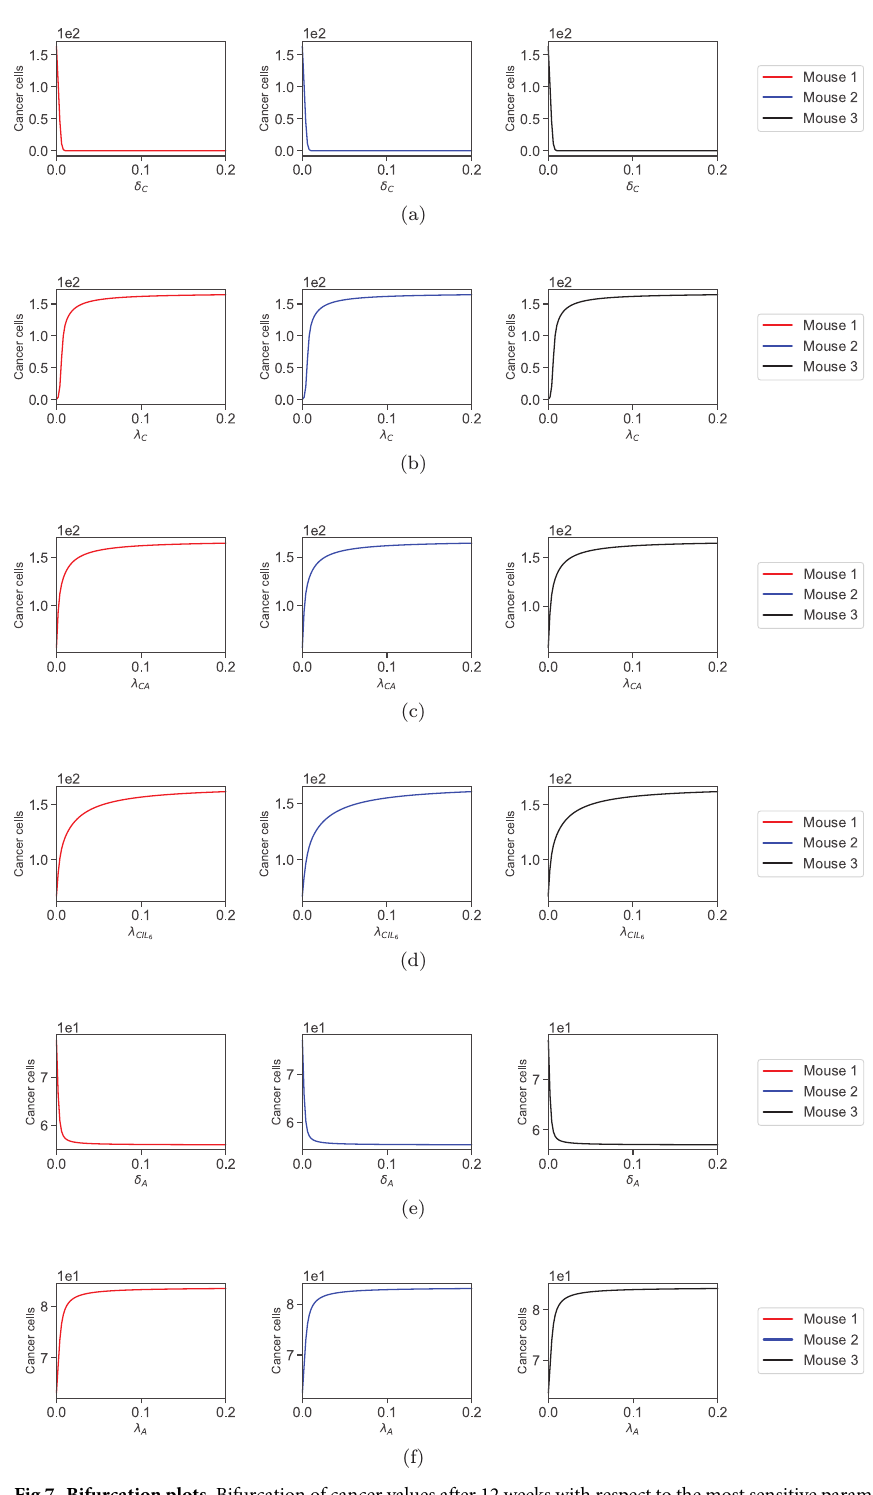
Fig 7. Bifurcation plots. Bifurcation of cancer values after 12 weeks with respect to the most sensitive parameters in Fig 4, namely (a)